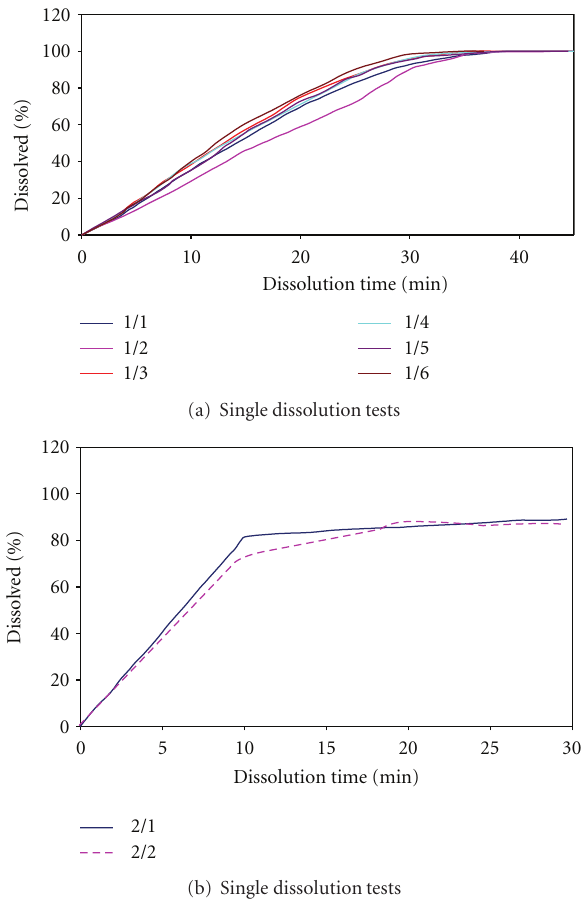
Figure 15: Photographs of ASA microparticles in di ff erent tablets. Figure 16: Release kinetics of acetylsalicylic acid from Bayer aspirin tablets (1) and “Black aspirin” tablets (2) (Data of Bayer